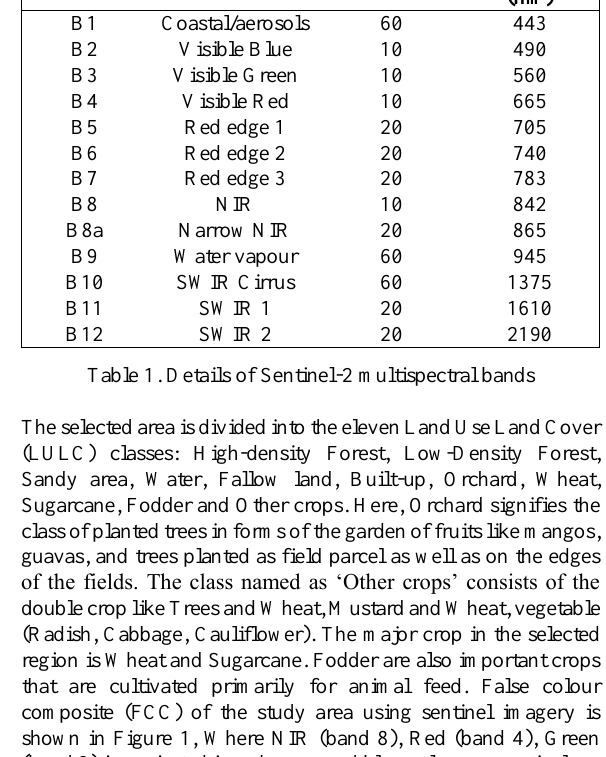
Figure 2. Flow chart of adopted